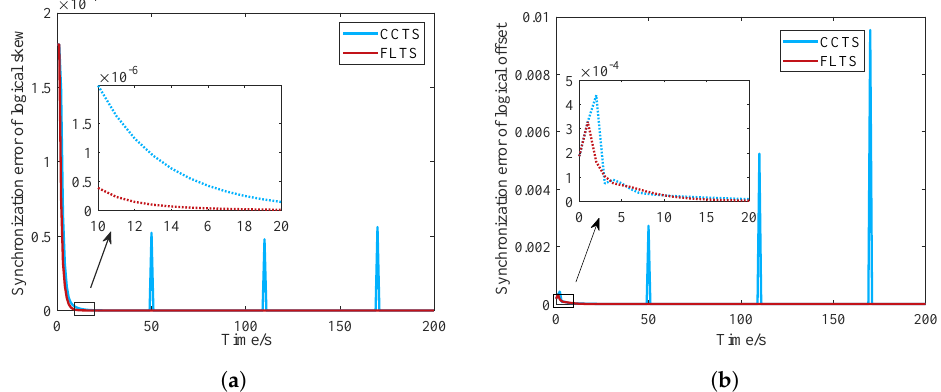
Figure 7. Convergence comparison of the logical clock against node mobility. ( a ) Logical clock skew; ( b ) Logical clock offset.